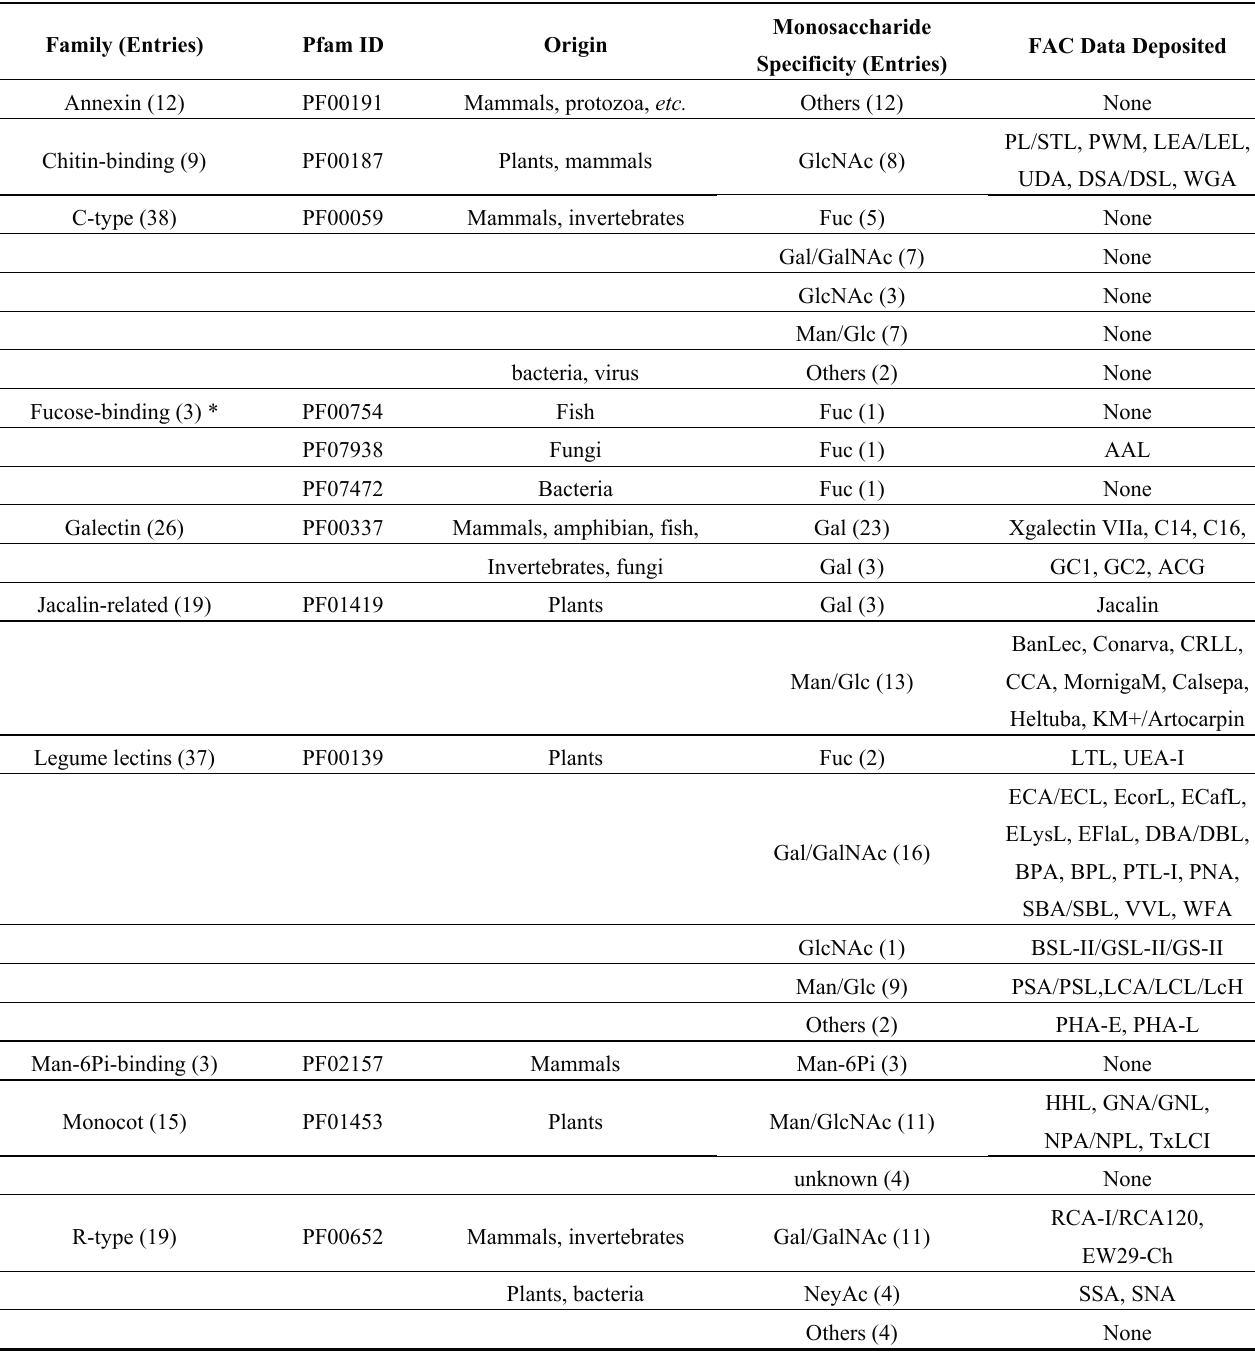
Table 2. Summary of lectin entries in the current Lectin f rontier DataBase (L f